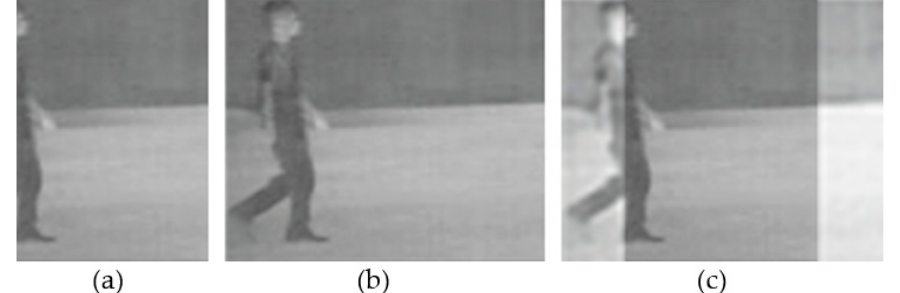
Figure 19. Example images of image prediction from fold-2: ( a ) original images; ( b ) GT images; ( c ) images predicted by the proposed method.